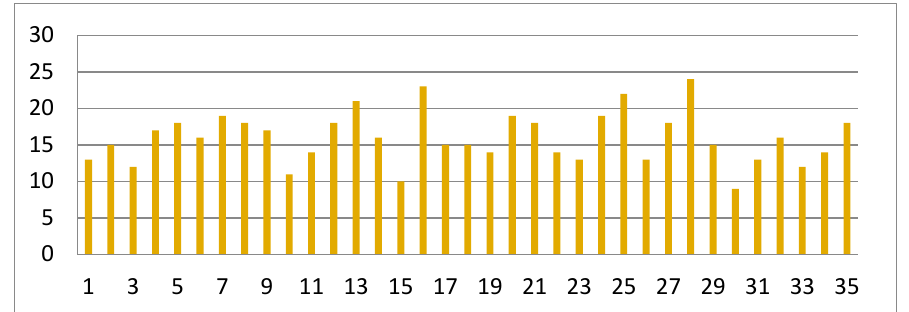
Figure 7.The visibility of the landmark in this paper